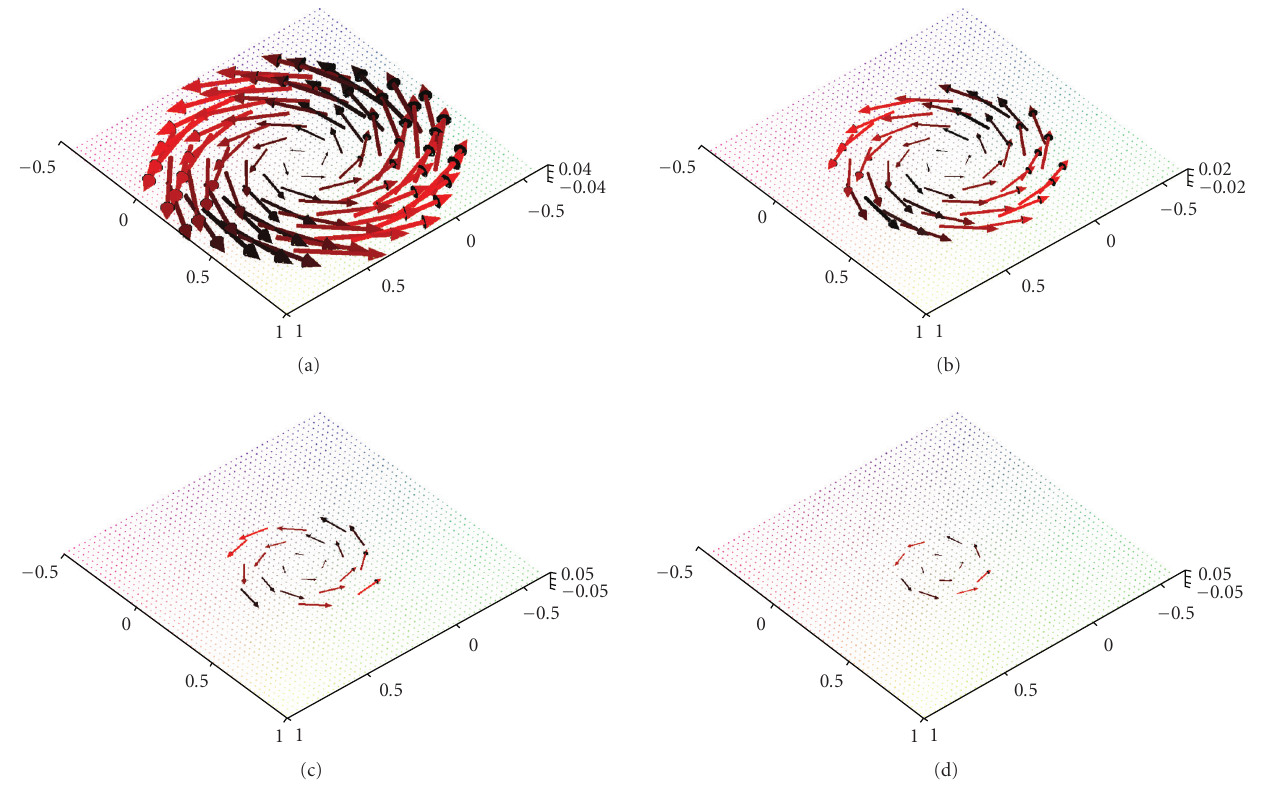
Figure 6: Reconstruction of the vector field f ( x ) = ( − x 2 , x 1 ,0) (cid:9) with the described algorithm for γ = 0 . 00692 using exact, simulated data D 1 f . (a),(b) The planes { x 3 = 0 . 5 } and { x 3 = 0 . 75 } . (c),(d) The planes { x 3 = 0 . 9 } and { x 3 = 0 . 95 }